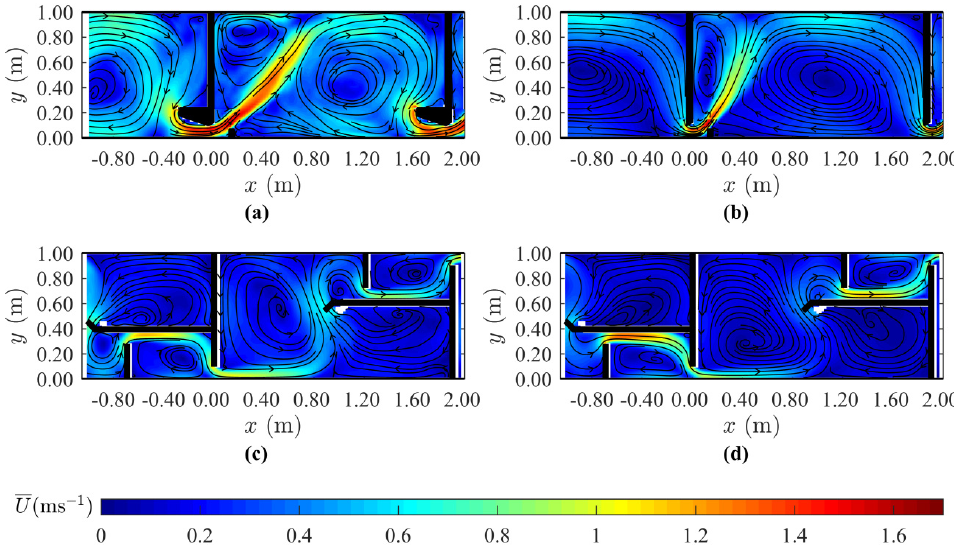
Figure 3. Mean velocity magnitude and 2D time-averaged streamline patterns at 0.2 m high from the bottom of the fishway (25% h m —pool mean water depth) in the four different fishway (VSF—vertical slot fishway; MSF—multislot fishway) configurations (VSF 1—Q = 112 L · s − 1 ; VSF 2—Q = 80 L · s − 1 ; MSF 1—Q = 58 L · s − 1 ; MSF 2—Q = 37 L · s − 1 ): ( a ) VSF 1; ( b ) VSF 2; ( c ) MSF 1; ( d ) MSF 2. Figure produced with FLOW-3D ® results. (Q, discharge).